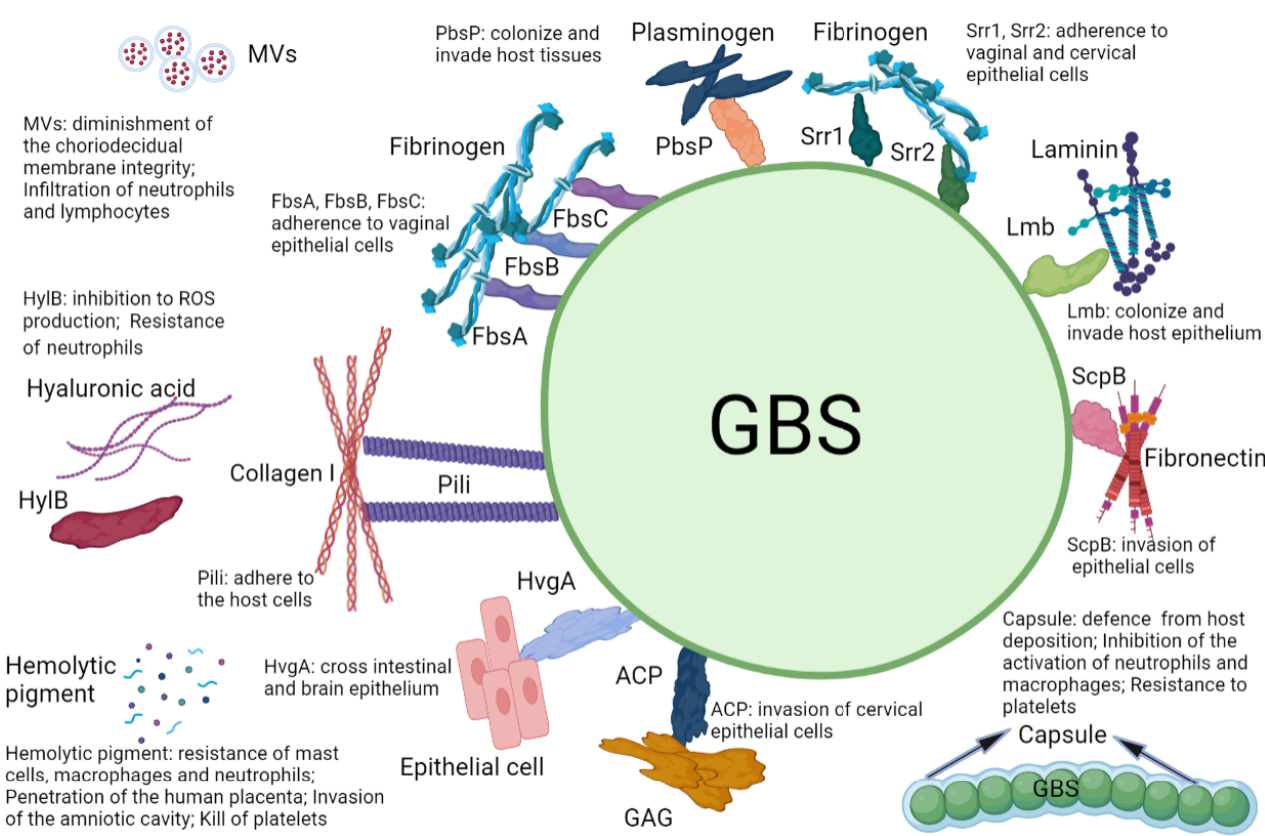
Figure 1. Summary of GBS virulence factors elucidated in this review, with their specific targets and mechanisms.